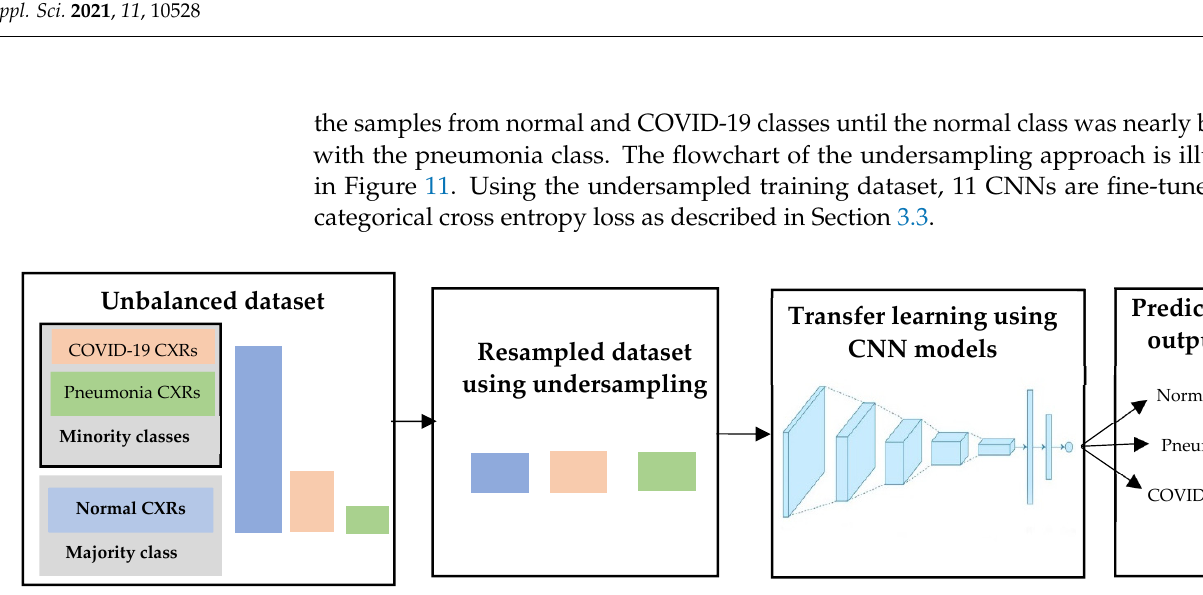
Figure 11. Deep learning with undersampling on the unbalanced dataset. Normal and COVID-19 CXRs were randomly removed to ensure a better balance with the number of pneumonia CXRs.